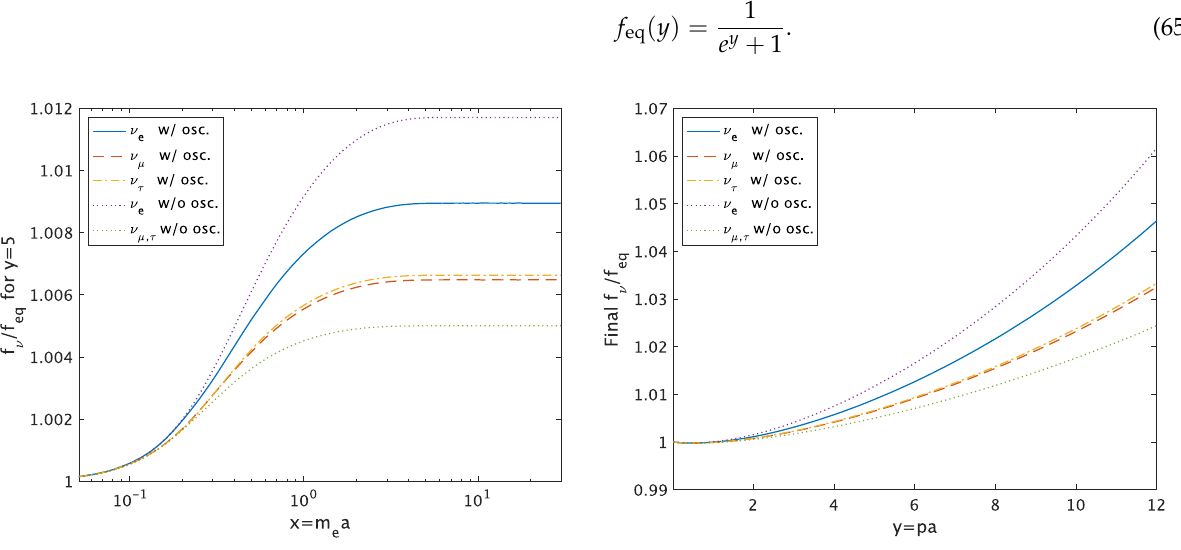
Figure 2. ( Left panel ): Time evolution of the distortions of flavor neutrinos for a fixed momentum ( y = 5) as a function of the normalized scale factor x = m e a with QED finite temperature corrections up to O ( e 3 ) . ( Right panel ): Final distortions of flavor neutrino spectra as a function of the comoving momentum y with QED finite temperature corrections up to O ( e 3 ) . Upper (lower) dotted line is for ν e ( ν µ , τ ) without neutrino oscillations, while inner solid and dashed lines represent those for flavor neutrinos with neutrino